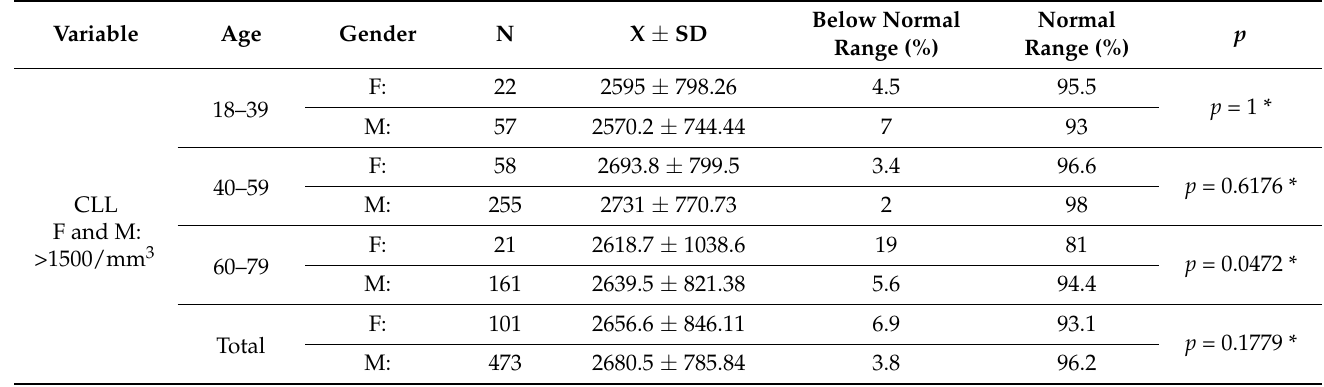
Table 5. Total leukocyte count in homeless people according to gender and